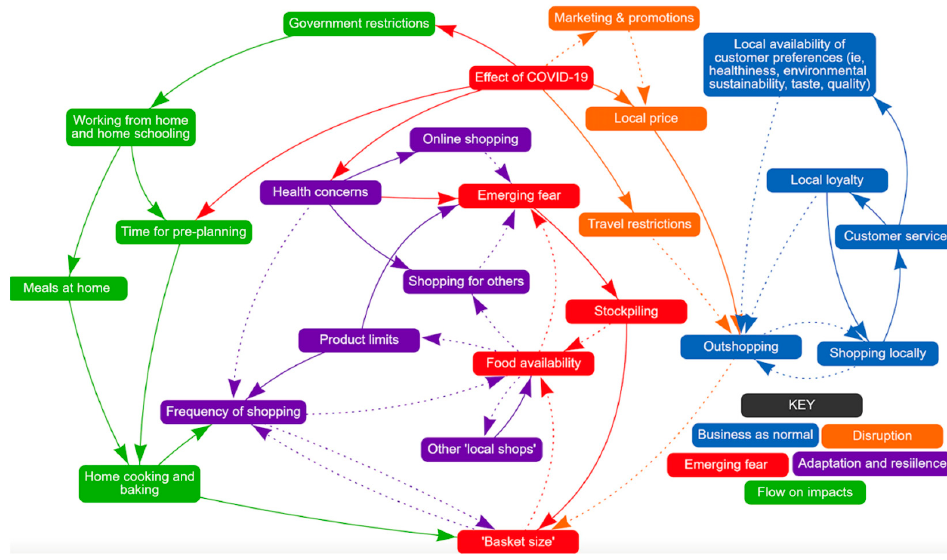
Figure 2. Factors influencing food supply and demand: customers’